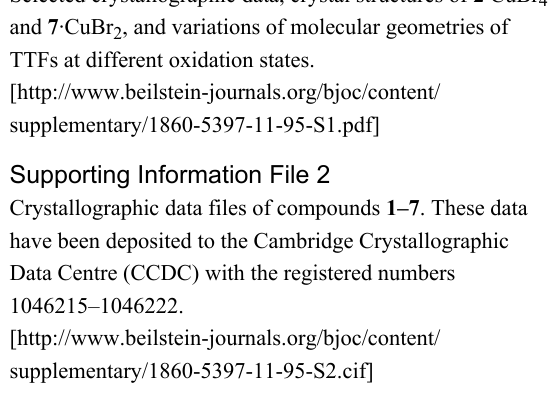
Figure 6: Temperature dependent magnetic susceptibility for the typical salts: a) 1 ·CuBr 4 with the insert panel depicting the Curie–Weiss fitting (red solid line) in low temperature region; b) 3 ·(CuBr 4 ) 0.5 ·CuBr 3 ·THF with the insert panel depicting the magnetic susceptibility at high temperature region; c) 5 ·Cu 2 Br 6 with the red solid line depicting the singlet-triplet fitting.